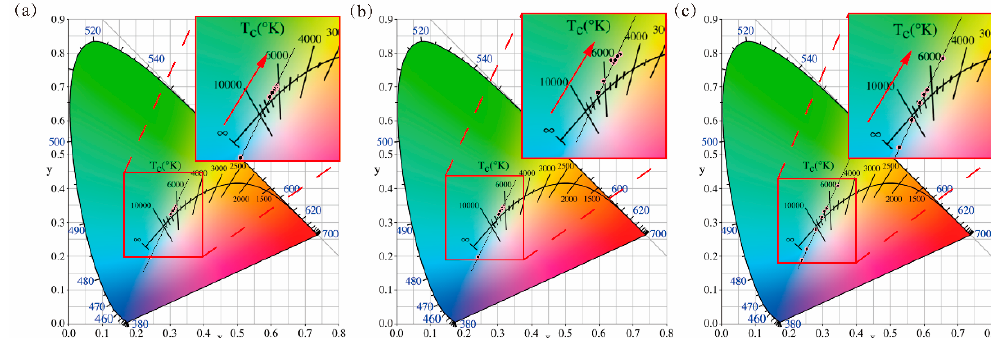
Figure 6. International Commission on illumination (CIE) chromaticity diagrams of ( a ) ATFPCs with different angles; ( b ) ATFPCs with different concentration; ( c ) CPCs with different concentration.